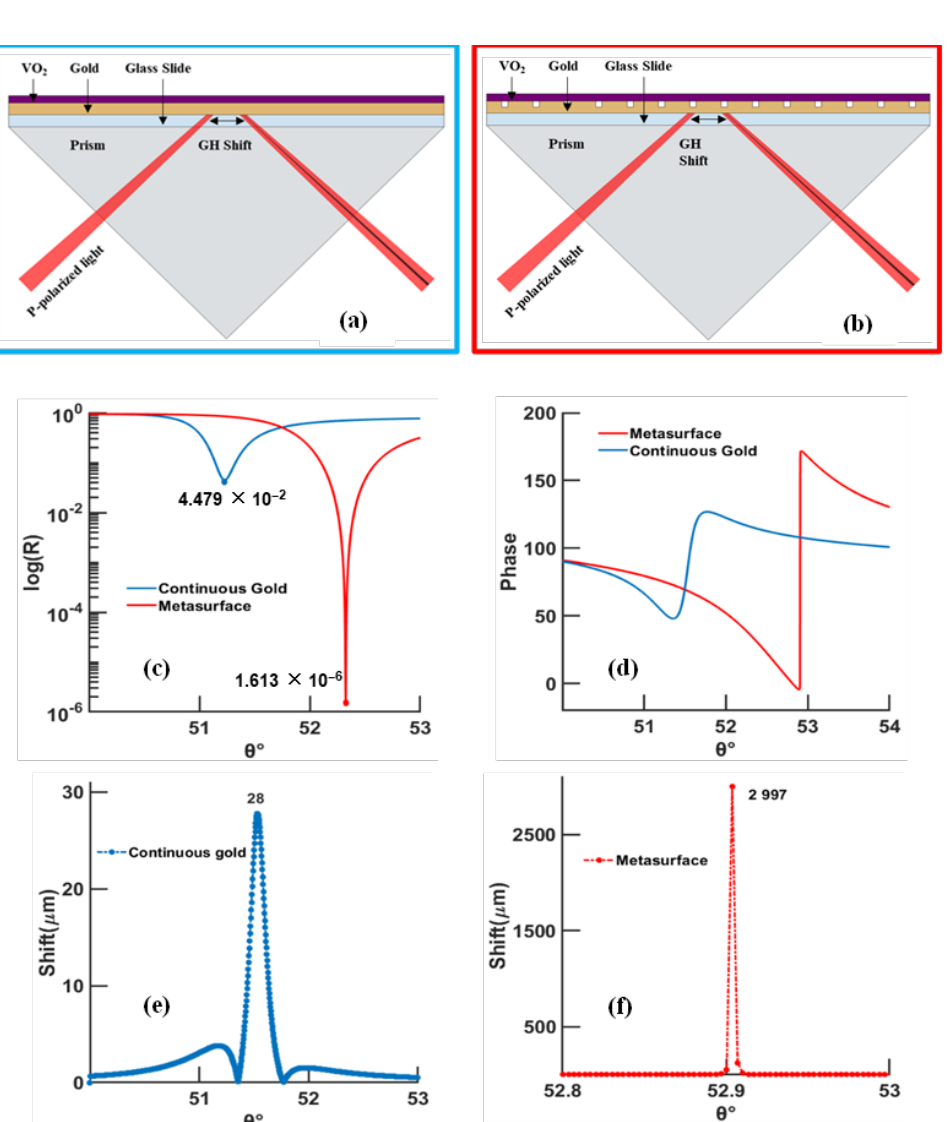
Figure 7. SPR curves calculated by TMM model, comparing the continuous gold configuration and the one with a metasurface, for an excitation of 1000 nm and VO 2 at 20 ◦ . The continuous gold thickness is equal to 50 nm, while the metasurface case includes a continuous gold layer of 30 nm and nanostructures at 20 nm depth; ( a ) schematic of the continuous gold configuration, ( b ) schematic of the metasurface configuration, ( c ) reflectivity, ( d ) phase, ( e ) Goos–Hänchen shift of continuous gold film (absolute value), and ( f ) Goos–Hänchen shift of gold metasurface (absolute value).